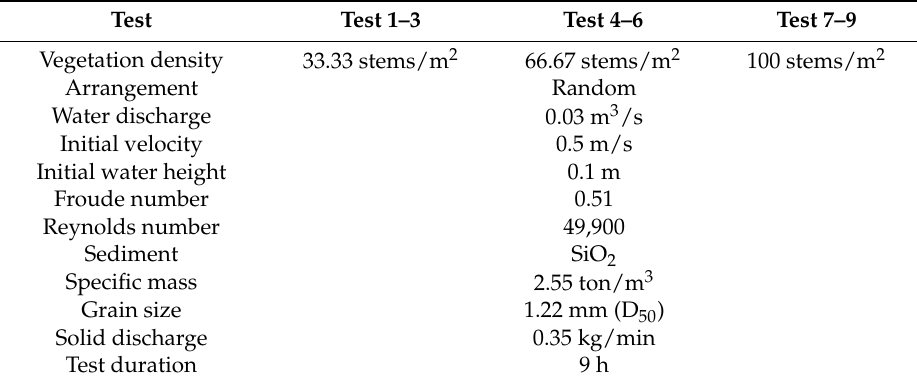
Table 1. Experimental parameters.